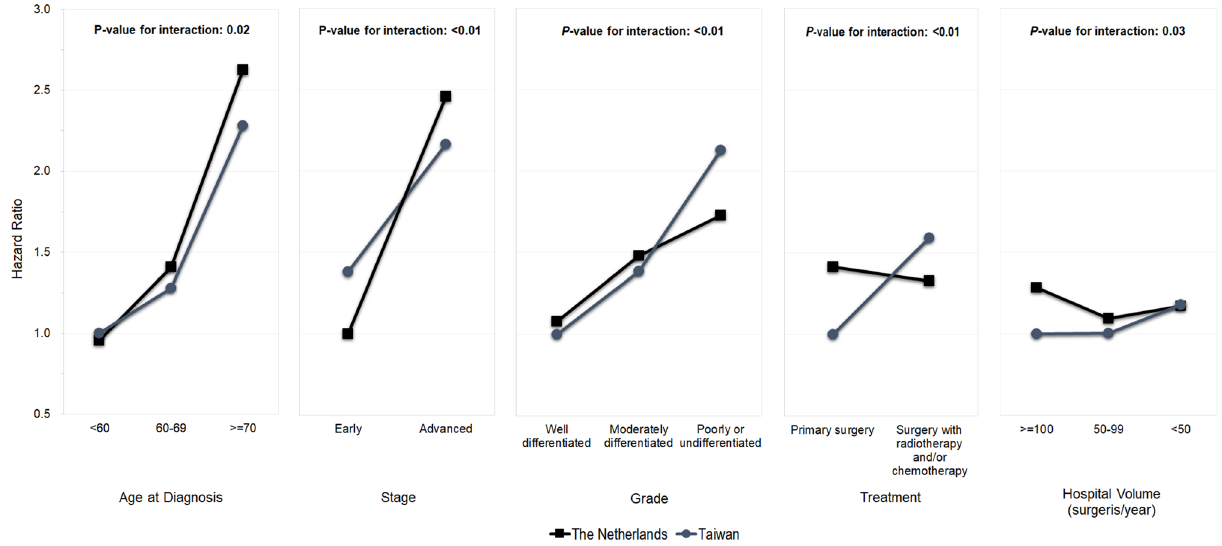
Figure 1. Interaction effects between country and five other prognostic